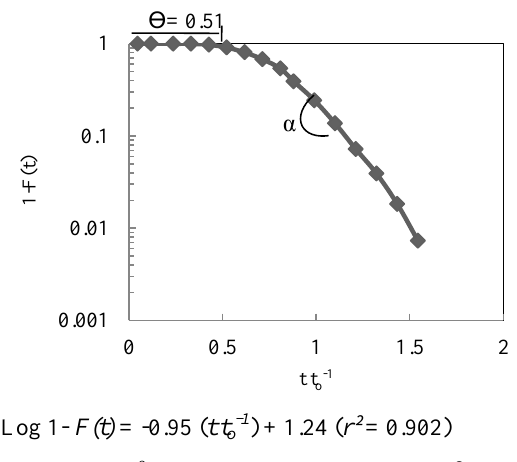
Figure 4. Hydraulic Wolf-Resnick model results for the